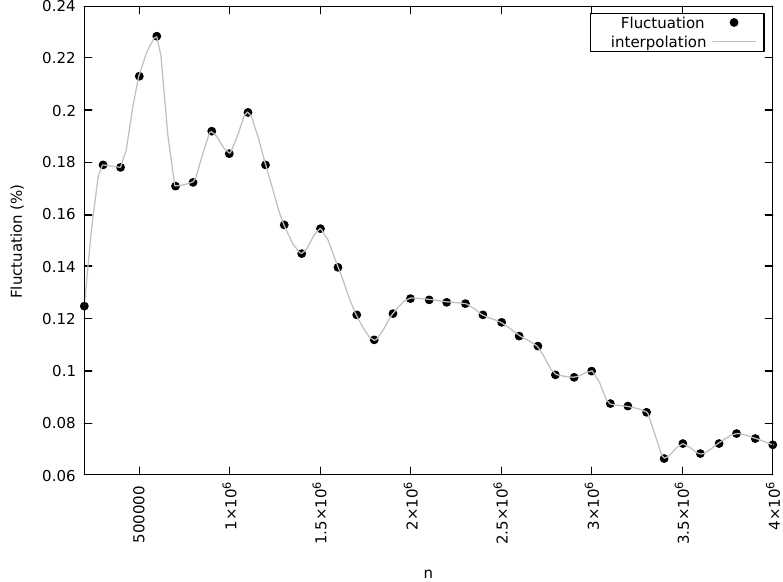
Figure 2. Difference of mod ( K ( n ) , n ) / n from a random uniform distribution, in